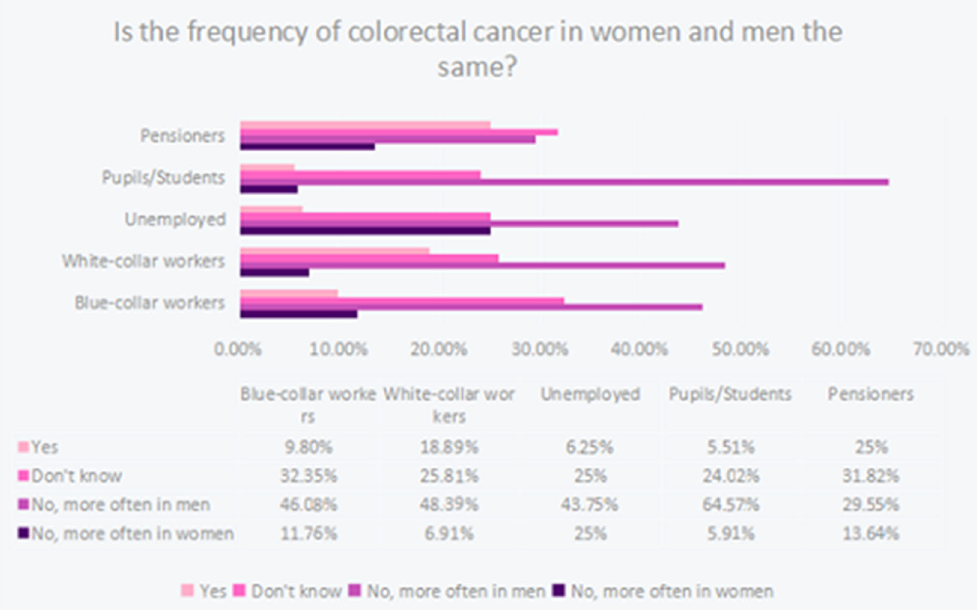
Figure 6. Frequency of colorectal cancer in women and men according to respondents’ knowledge (specifying professional groups).